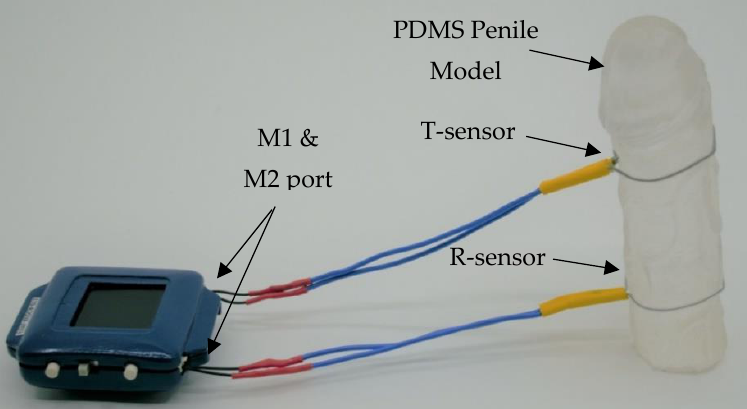
Figure 3. Illustration of the waist detector and microtubular sensors in operation around a dummy PDMS-based penile model.